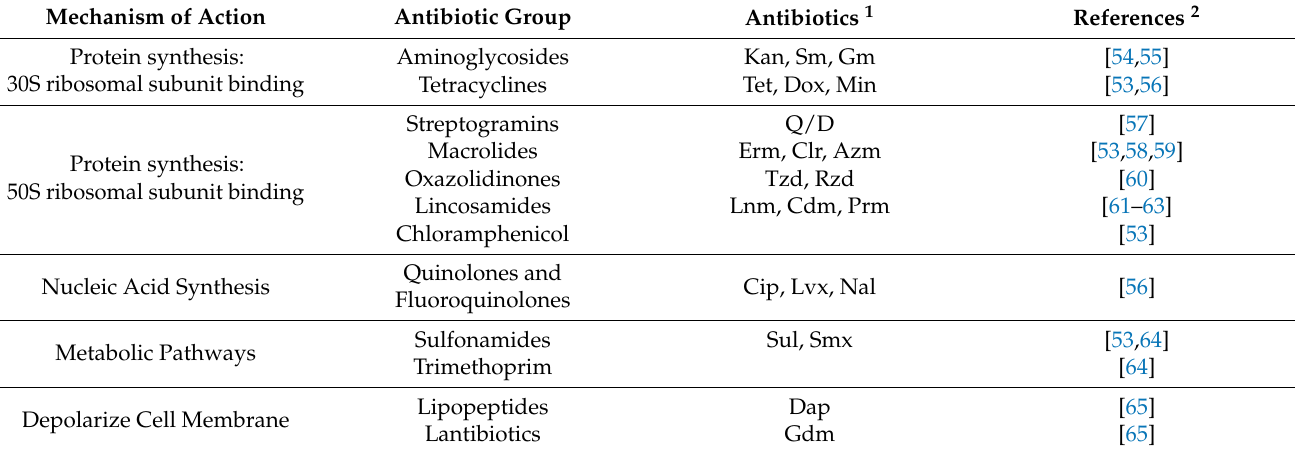
Table 1. The role of MDR pumps in antibiotic resistance. Antibiotics groups by mechanism of